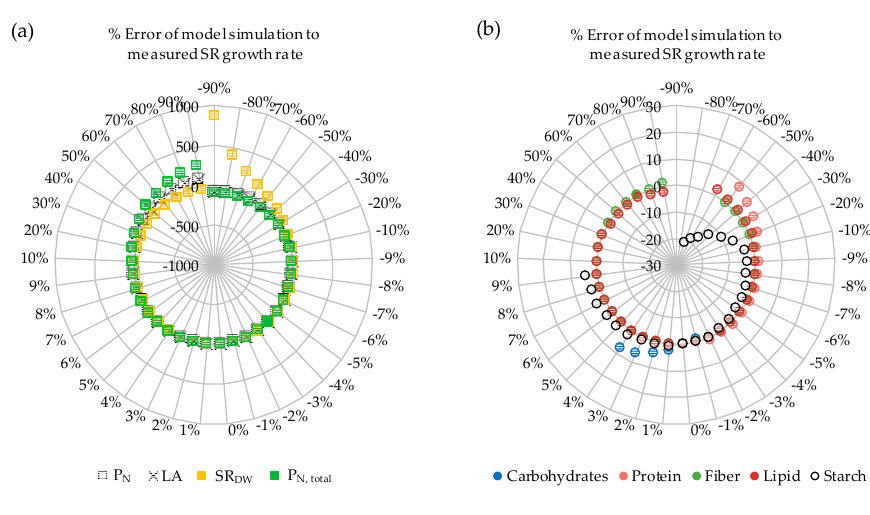
Variation of model % Changes of simulated growth rate with respect to the original data data values (%) Specific sucrose uptake rate related data Biomass function related